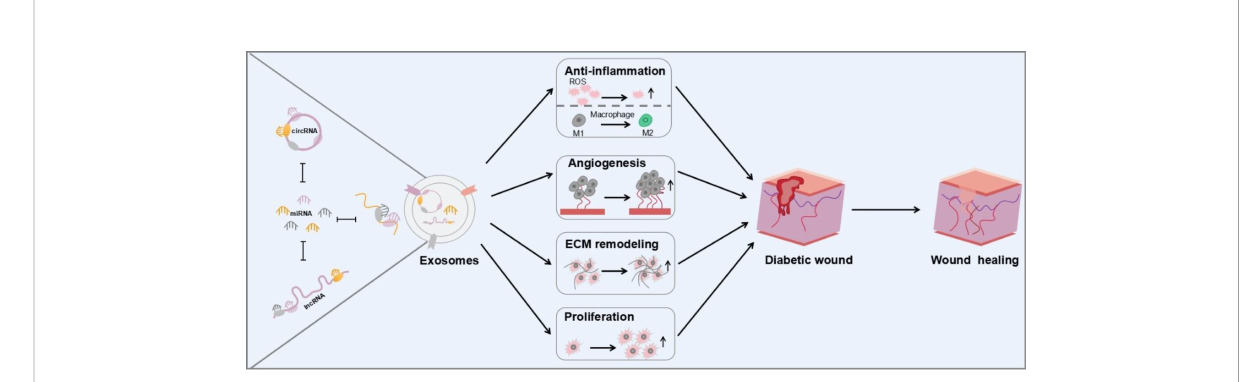
SCHEME 1 Schematic illustration of ncRNA carried by exosomes for diabetic wound